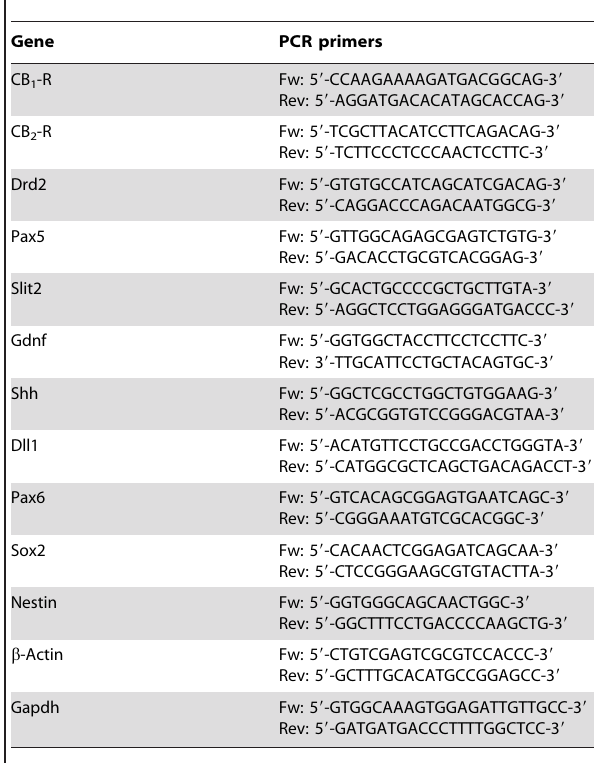
Table 1. List of the primers used for qPCR